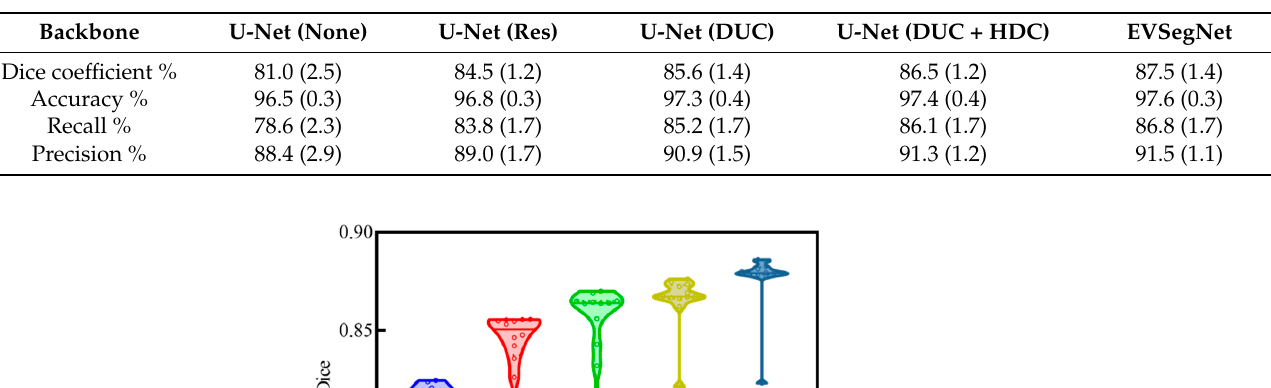
Figure 6. Illustration of segmentation results of VWI dataset. The first column represents the original image, the second column represents the mask, the third column is binary mas, the fourth represents the edgemaps, which are generated by using Canny filter, and the last column is the corresponding results of the prediction. Table 1. The Comparison of Segmentation Results of Different Backbone Architecture.